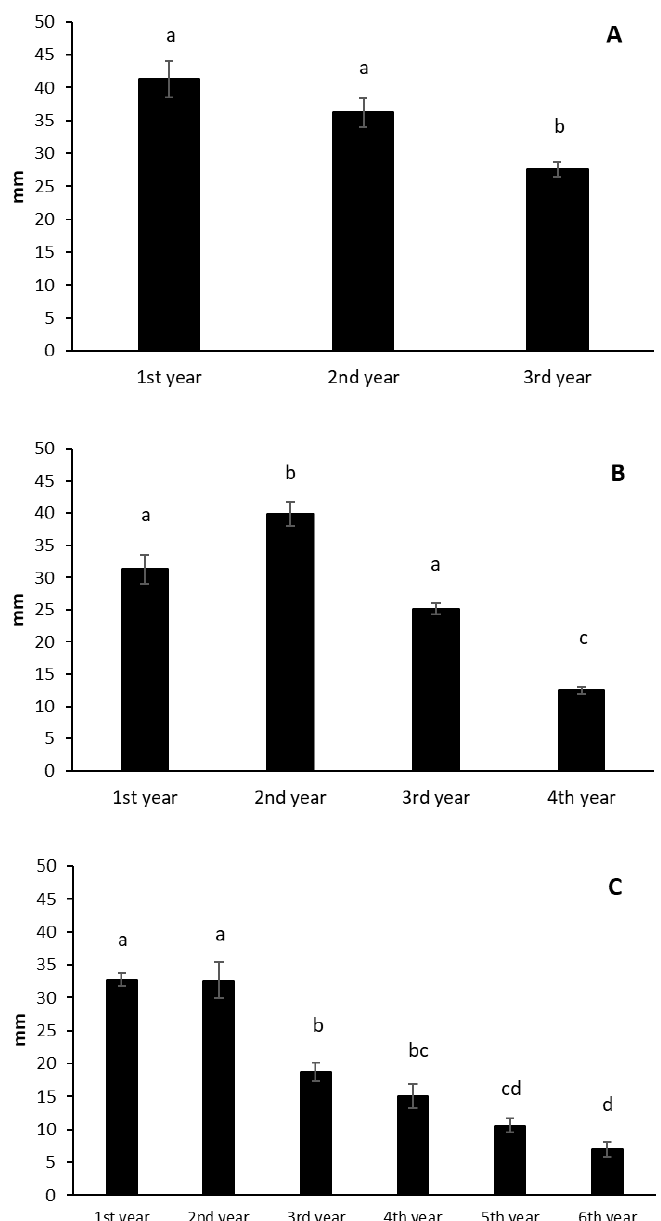
Figure 4. Annual ring thickness (mm) at plantations ( A – C ). Values are reported as mean ± s.e. Different letters at the tops of the bars indicate a significant difference among values measured for the plantations.